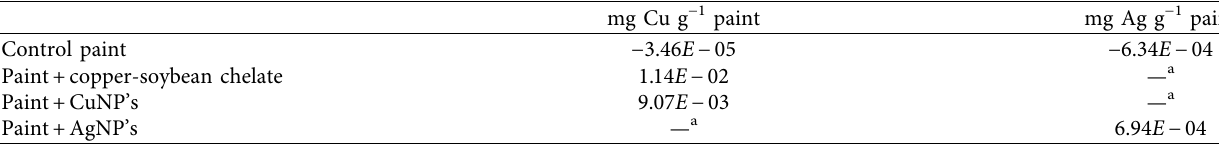
Table 3: Cu and Ag species concentration in